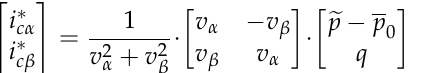
Figure 3. Compensation of power components 𝑝 , 𝑞 ,